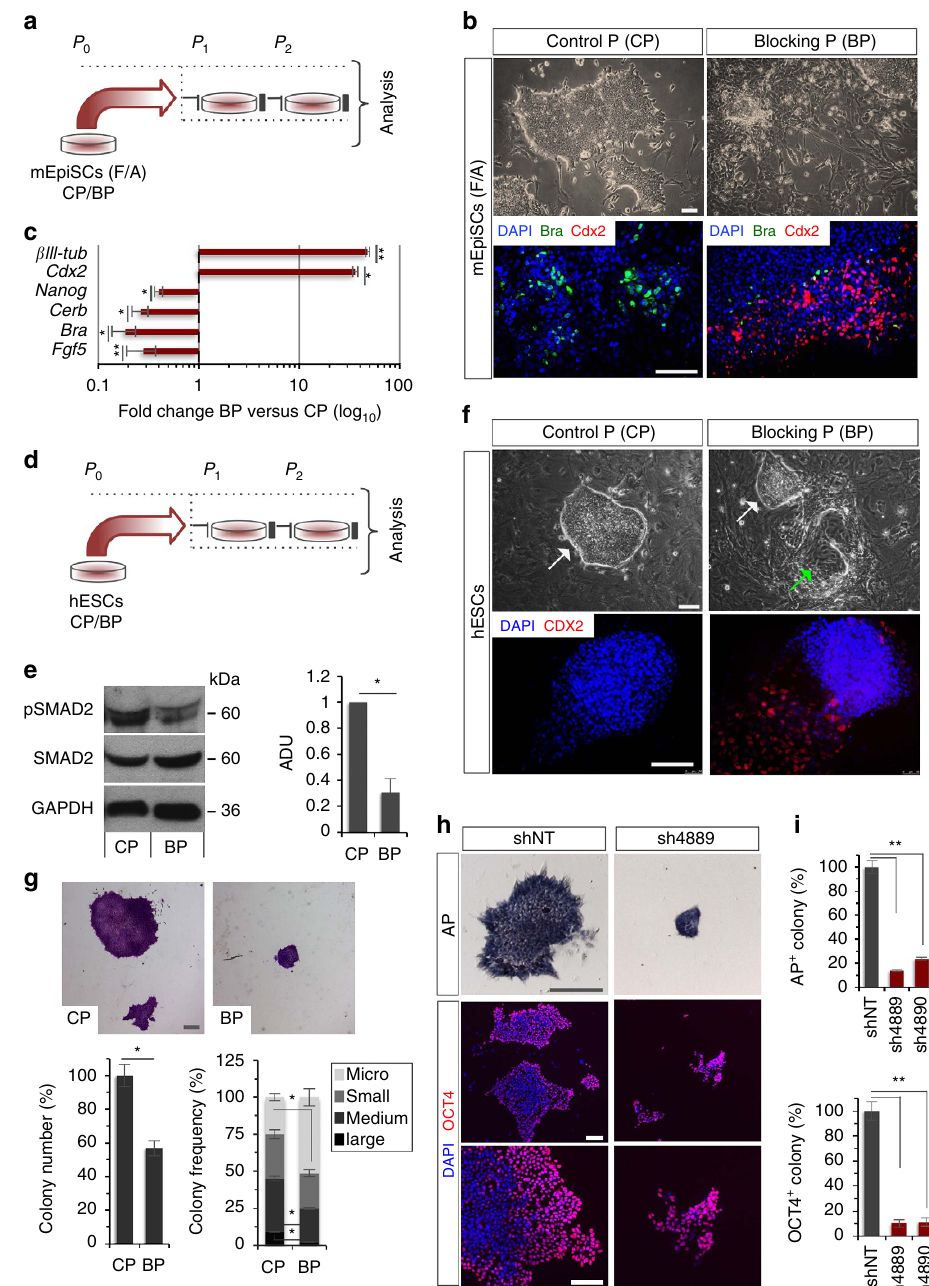
Figure 8 | Cripto is required for maintenance of mouse and human primed pluripotent stem cell states. ( a ) Schematic representation of the experimental procedure. ( b ) Representative photomicrographs of brightfield (scale bar, 100 m m) CP/BP-treated F/A EpiSCs colonies (top panels) and immunostaining detection of Bra/Cdx2 (bottom panels) in F/A EpiSCs, after two passages with CP/BP. Nuclei were stained with 4,6-diamidino-2- phenylindole (DAPI). ( c ) qPCR analysis of EPI -associated ( Fgf5 , Brachyury ( Bra ), Cerberus ( Cer ) and Nanog ), trophoblast ( Cdx2 ) and neural ( b III-tubulin ) markers in BP/CP-treated F/A mEpiSCs. Data are expressed as fold change of BP versus CP after normalization to Gapdh and are mean ± s.e.m. ( n ¼ 3; * P o 0.01 and ** P o 0.005). ( d ) Schematic representation of the experimental procedure. hESCs were passaged either on feeder layer or in Matrigel/feeder-free conditions and in the presence of CP/BP. ( e ) Western blot analysis of pSMAD2 protein levels in CP/BP-treated hESCs (1 week). SMAD2 and GAPDH were used as loading controls. The densitometric analysis is expressed in arbitrary unit (ADU) as the pSMAD2/SMAD2 ratio. ( f ) Representative phase contrast pictures (upper panels) of CP/BP-treated hESC colonies after two passages on feeder layer. White and green arrows indicate undifferentiated and differentiated colonies, respectively. Representative picture of CDX2 immunostaining (lower panels) in CP- and BP-treated hESCs. Nuclei were stained with DAPI. Scale bars, 100 m m. ( g ) Clonogenic assay of hESCs treated with CP and BP for two passages on Matrigel-coated plates. Representative pictures of CP- and BP-treated hESC colonies, stained with crystal violet (top panels). Scale bar, 200 m m. Colony number (bottom left panel) and phenotype frequency (bottom right panel). Data are mean ± s.e.m. ( E 100 colonies scored/condition; * P o 0.01). ( h ) Representative photomicrographs of hESC colonies derived from shNT Control and sh4889 CRIPTO KD hESCs, and stained for AP (top panels; scale bar, 200 m m) or OCT4 (bottom panels; scale bar, 100 m m). ( i ) Quantification of AP þ (top panel) and OCT4 þ (bottom panel) colonies. The number of AP þ and OCT4 þ colonies is shown as percentage over shNT hESCs. Data are mean ± s.e.m. ( n ¼ 3; ** P o 0.005). NATURE COMMUNICATIONS|7:12589|DOI: